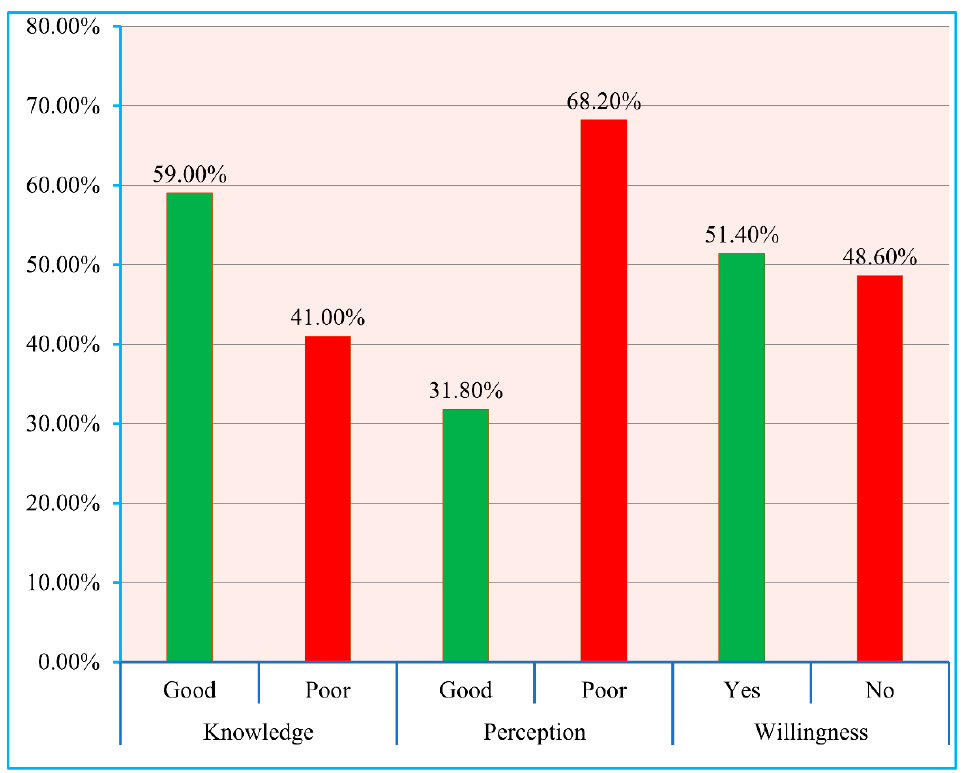
Figure 1. Percentage distributions of knowledge (good and poor), perception (good and poor), and willingness (yes and no) for taking COVID-19 vaccine among Bangladeshi population. All respon- dents’ scores were calculated through descriptive statistics and categorized into good knowledge and perception (if the participants’ score was greater than or equal to the mean value) and poor knowledge and perception (if the participants’ score was less than the mean value)